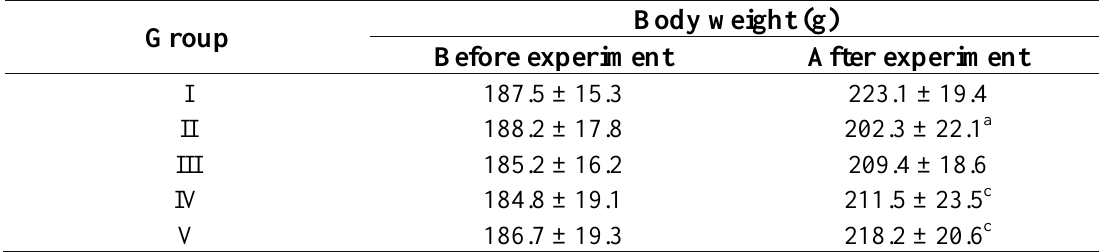
Table 1. Effect of Lycopene treatment on body weight of gastric cancer rats.